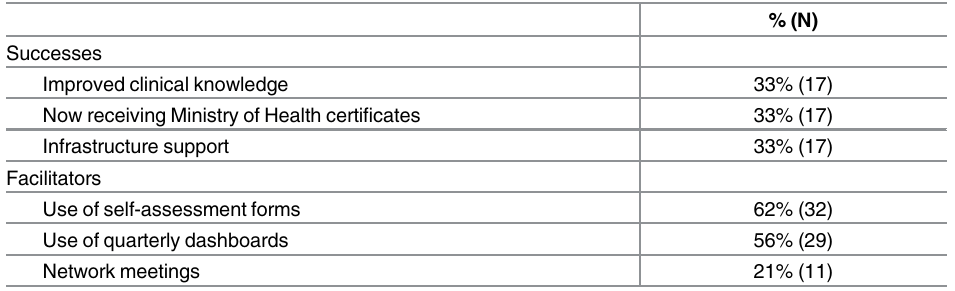
Table 2. Success and Facilitators of EQUIP Mentorship (N =